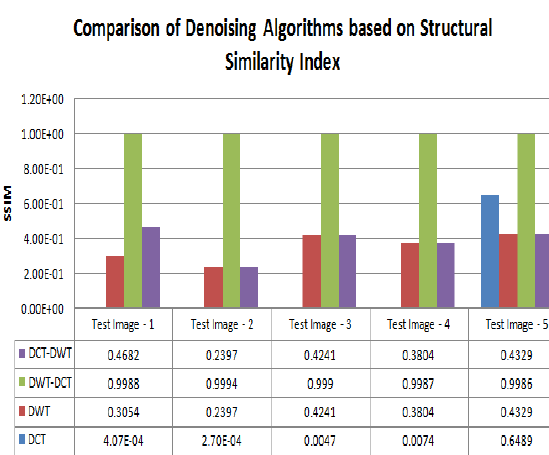
Figure 20. Comparison of Denoising Algorithms based on Structural Similarity